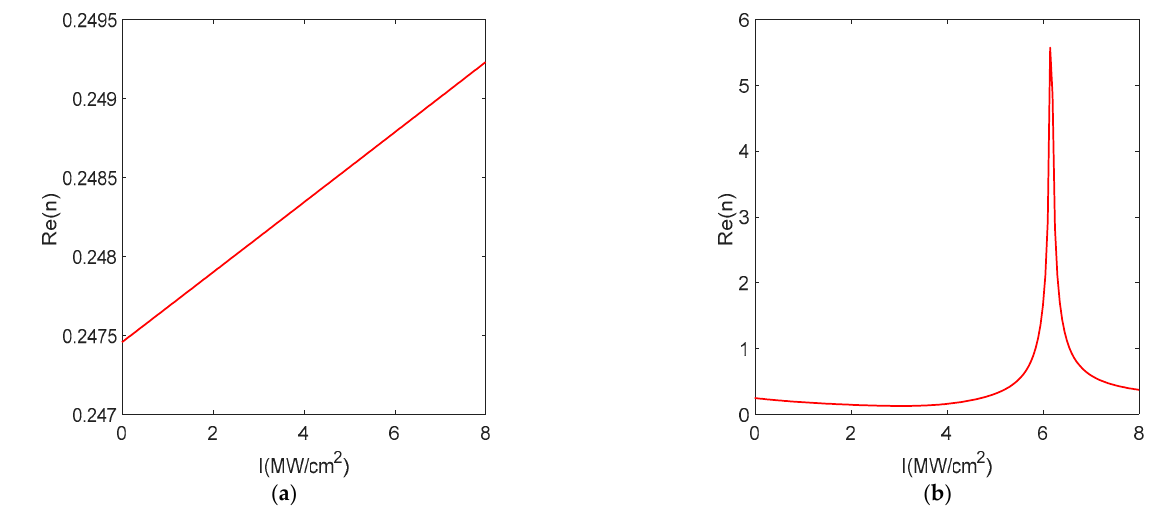
Figure 8. Intensity − dependent refraction index of the multilayered metamaterials at 710.8 nm. ( a ) Without the gain medium. ( b ) With the gain medium. ( a ) Without the gain medium. ( b ) With the gain